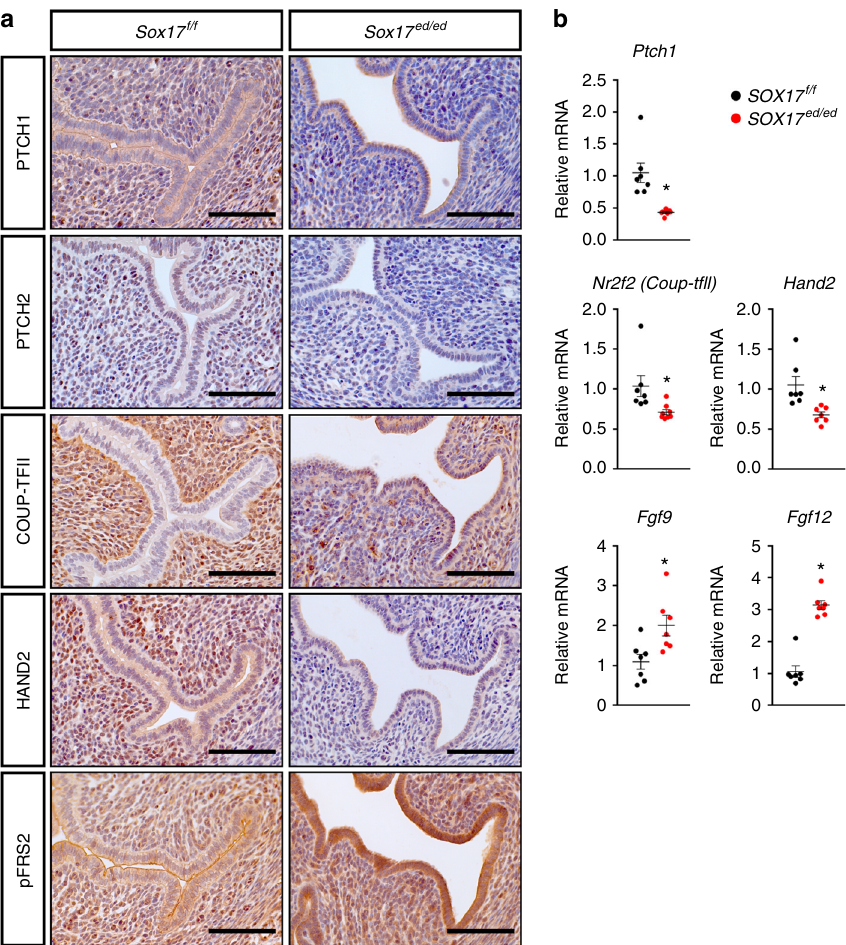
Fig. 3 Alteration of Indian Hedgehog (IHH) signaling pathways during the window of receptivity. a Immunohistochemical staining of IHH receptors PTCH1 and PTCH2, as well as downstream mediator COUP-TFII, HAND2, and phosphorylated FRS in GD 3.5 uteri from Sox17 f/f and Sox17 ed/ed mice ( n = 3). Scale bars: 100 µ m. b Quanti fi cation of IHH signaling-associated genes in GD 3.5 uteri from Sox17 f/f (black dots) and Sox17 ed/ed (red dots) mice ( n = 7). * P < 0.05 (Student ’ s t test). Data are presented as means ±